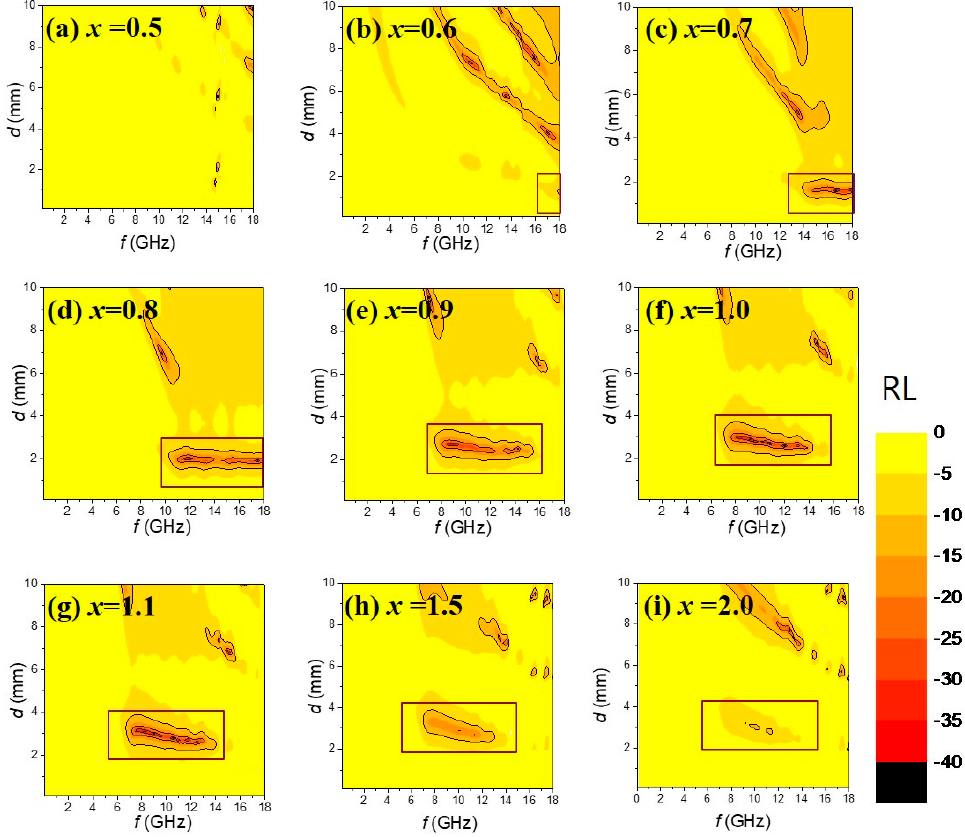
Figure 7. ( a – i ) RL map as functions of sample thickness ( d ) and frequency ( f ) for SrFe 12 − 2x Zn x Zr x O 19 ( x = 0.5, 0.6, 0.7, 0.8, 0.9, 1.0, 1.1, 1.5, 2.0) powder–epoxy (10 wt%) composite samples.